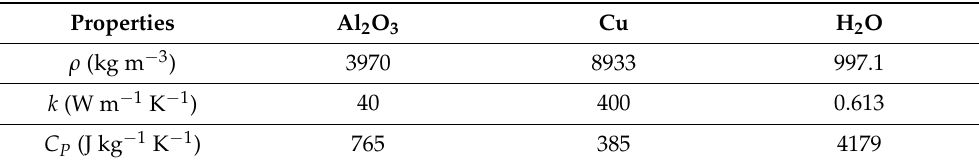
Table 1. Thermophysical attributes of base fluid (H 2 O) and nanoparticles (Al 2 O 3 and Cu) (referring to Waini et al. [8]).